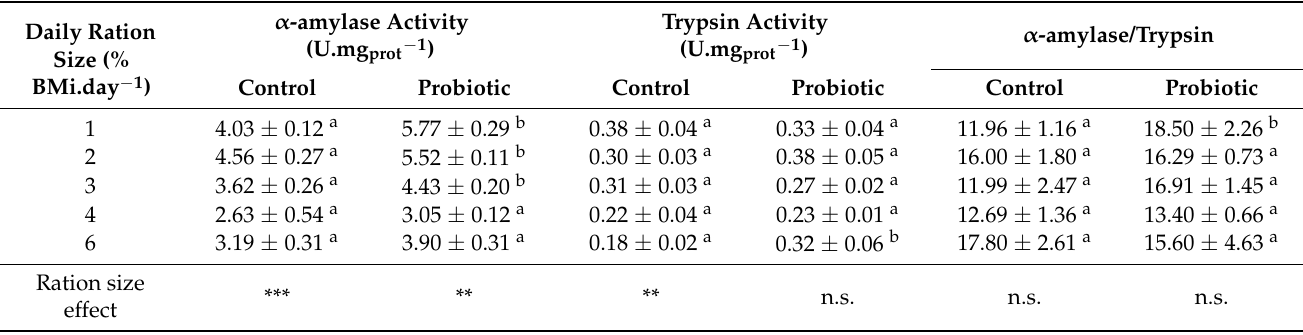
Table 8. Specific activities of digestive enzymes in the digestive gland of L. stylirostris per test diets at each ration size tested. Values given as mean ± SD with n = 3. For each parameter, different letters within the same raw indicate significant differences between diets by pairwise comparisons using Fisher’s Protected Least Significant Difference (PLSD). The ration-size effects were assessed by a Kruskal–Wallis test (n.s., non-significant; ** p < 0.01; *** p <